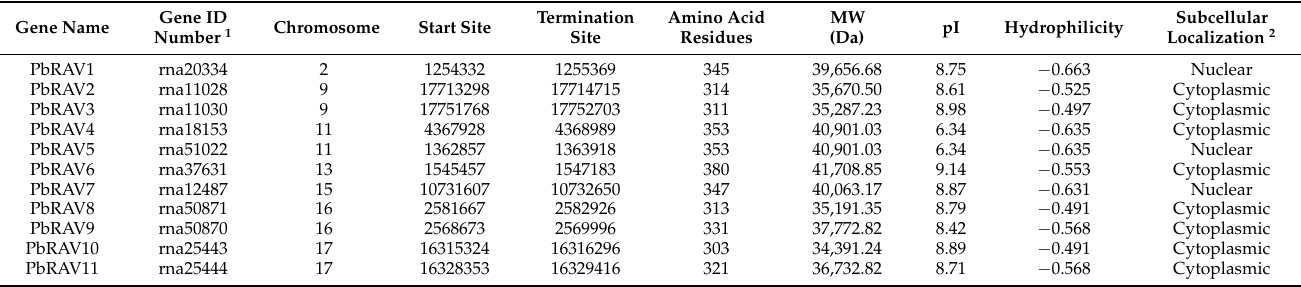
Table 1. General information on Pyrus bretschneideri RAV genes.